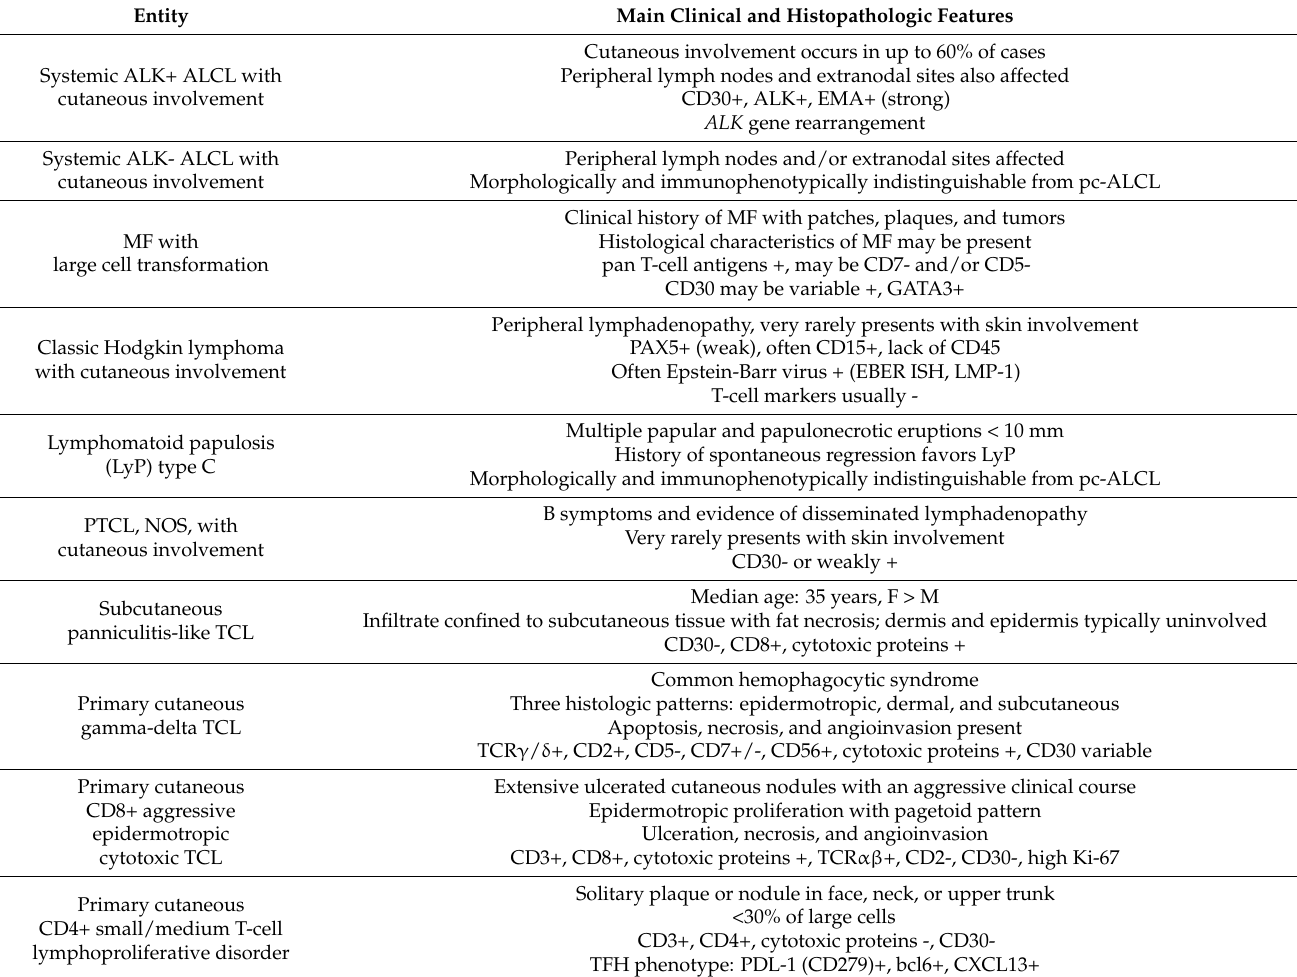
Table 3. Differential diagnoses of primary cutaneous